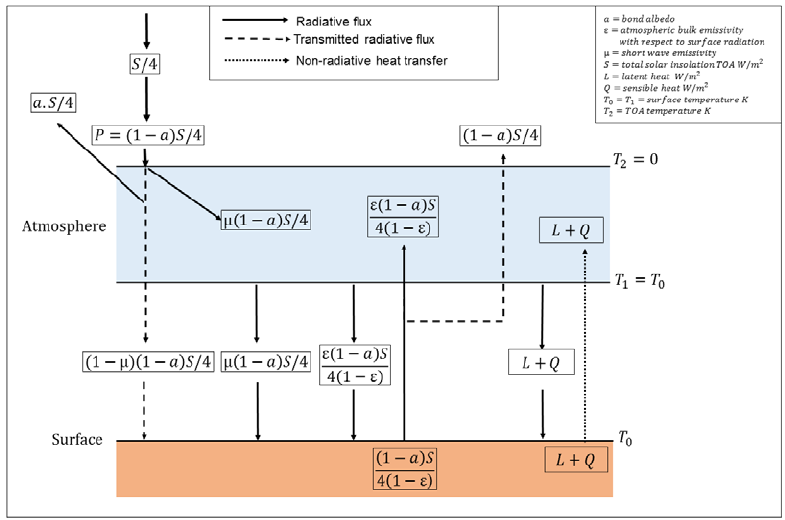
Figure 3. Equilibrium adiabatic radiative model with fluxes given as functions of S , a , ε , µ , L & Q . All of the units are in W/m 2 except temperatures T 0 , T 1 , T 2 , which are in Kelvin.